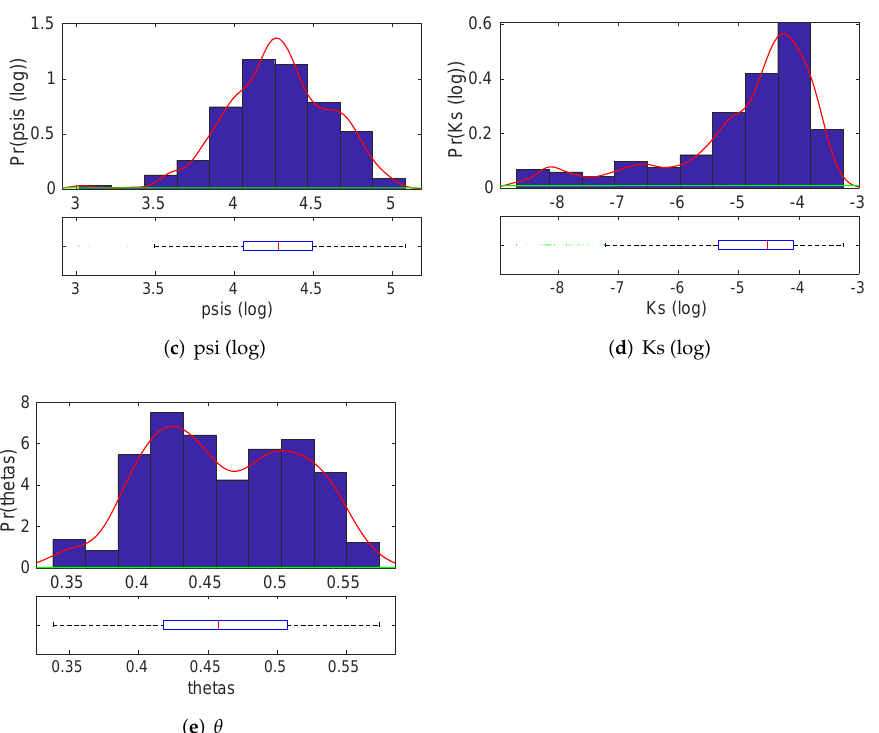
Figure 6. A posteriori distributions of the input parameters of CLM4 for a given output u f . The red line indicates the posterior density, whereas the green line indicates the prior density of the parameter. (BMA evaluation).